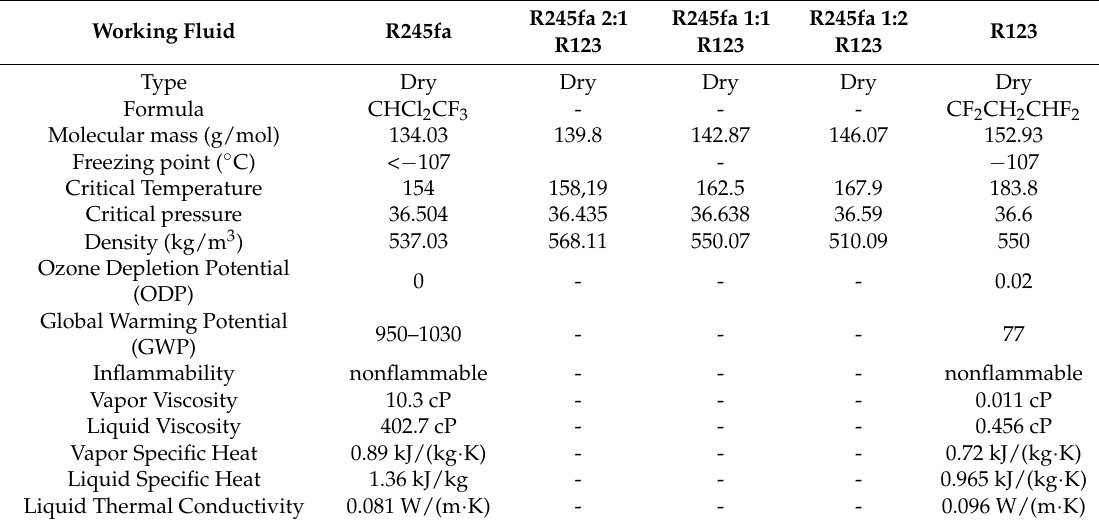
Table 3. Thermo-physical properties of R245fa, R123, and mixture ratio.